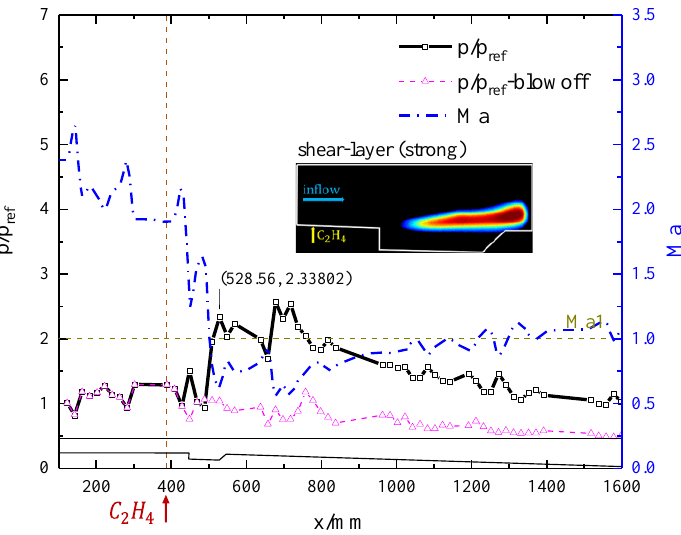
Figure 7. Dimensionless pressure/Mach number along x axis and mean pseudo-color image of CH* chemiluminescence at Case 11 (1.7D 0 I0.144).